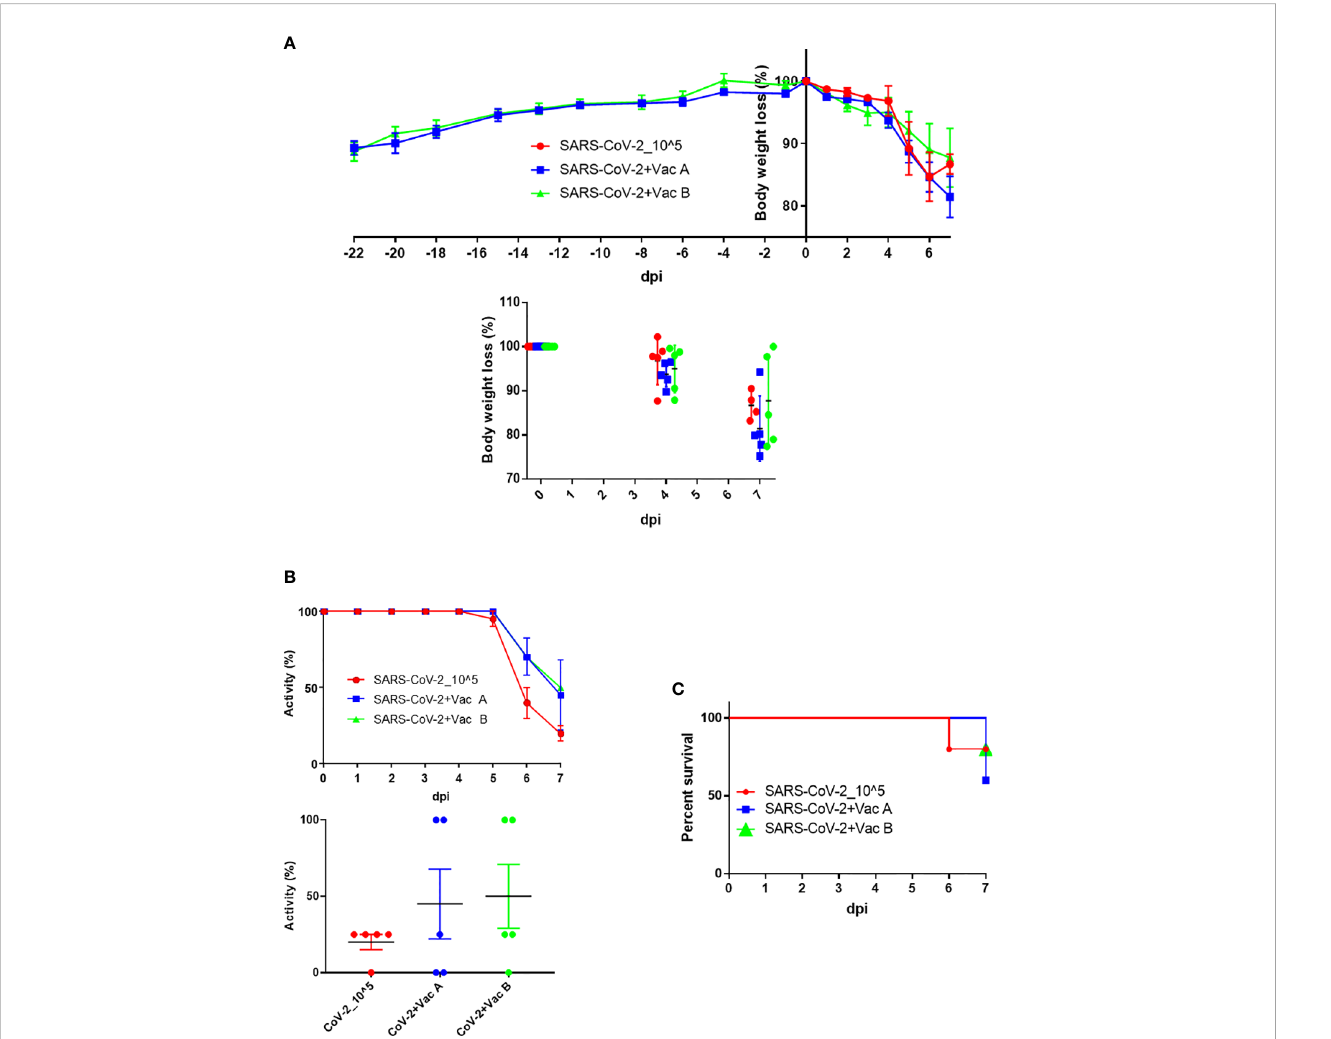
FIGURE 3 Body weight, activity, and survival changes in SARS-CoV-2-vaccinated and infected mice. (A) Weight changes starting from injection time (upper panel) and/or while infection (lower panel) plotted as percent change to compare the weight change of three groups (each group has n = 5); both the SARS-CoV-2-infected group (vaccine A, and vaccine B) and the vaccine-treated groups were autopsied; thus, mice ’ s body weights were monitored until 7 days postinfection (dpi). (B) Activity changes from day 0 up to day 7 postinfection (upper panel), and the overall activity changes (lower panel) plotted as percent change to compare the activity change of three groups after infection (each group has n = 5); both the SARS-CoV-2-infected group and the vaccine-treated groups (vaccine A and vaccine B). (C) The survival of mice was monitored every day until mice of the three groups were autopsied on day 7 dpi. Means with SD are presented, and there was no signi fi cance among